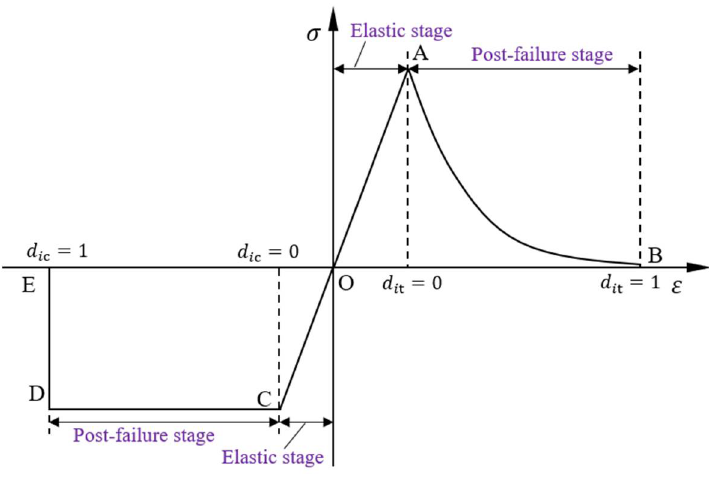
Figure A1. Schematic view of the stress–strain curve for intra-layer material.